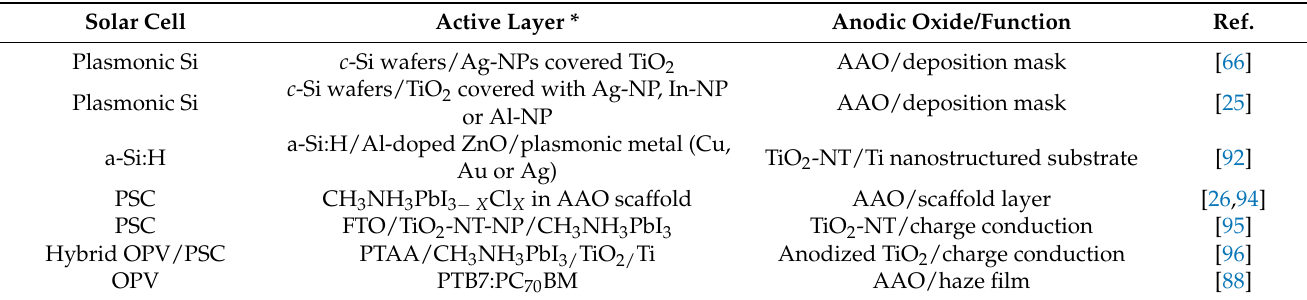
Table 2. Other functionalities of anodic oxides prepared via anodization in silicon, PSC, and OPV solar cells. Solar Cell Active Layer * Anodic Oxide/Function Ref. Plasmonic Si AAO/deposition